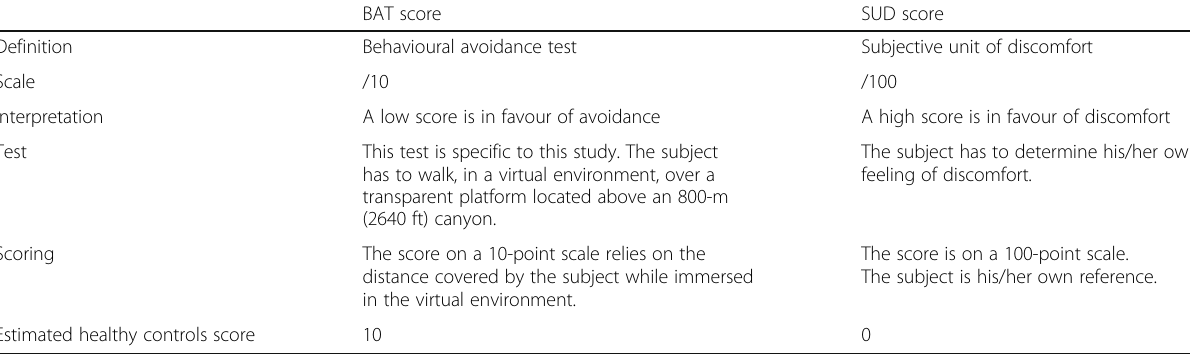
Table 2 BAT and SUD scores ’ characteristics